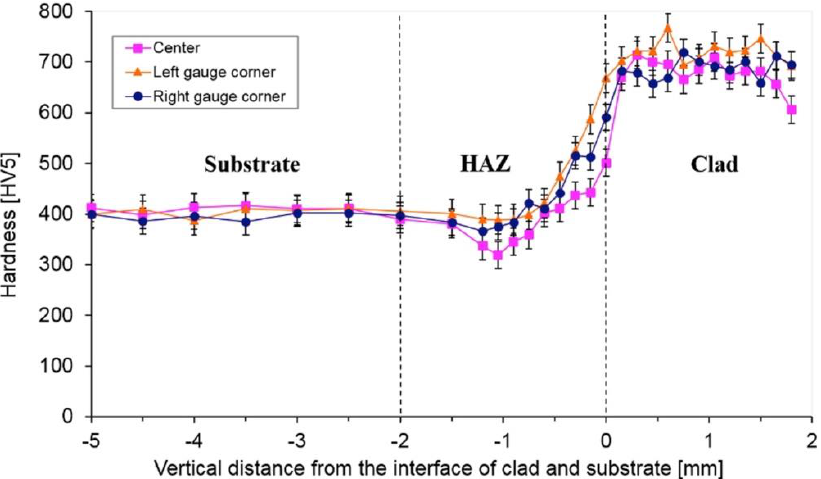
Figure 10. Hardness variation in the clad, HAZ, and substrate during LC of 410L stainless steel on railroad steel. Reproduced with permission from [22]. Copyright Elsevier, 2017. railroad steel. Reproduced with permission from [22]. Copyright Elsevier,